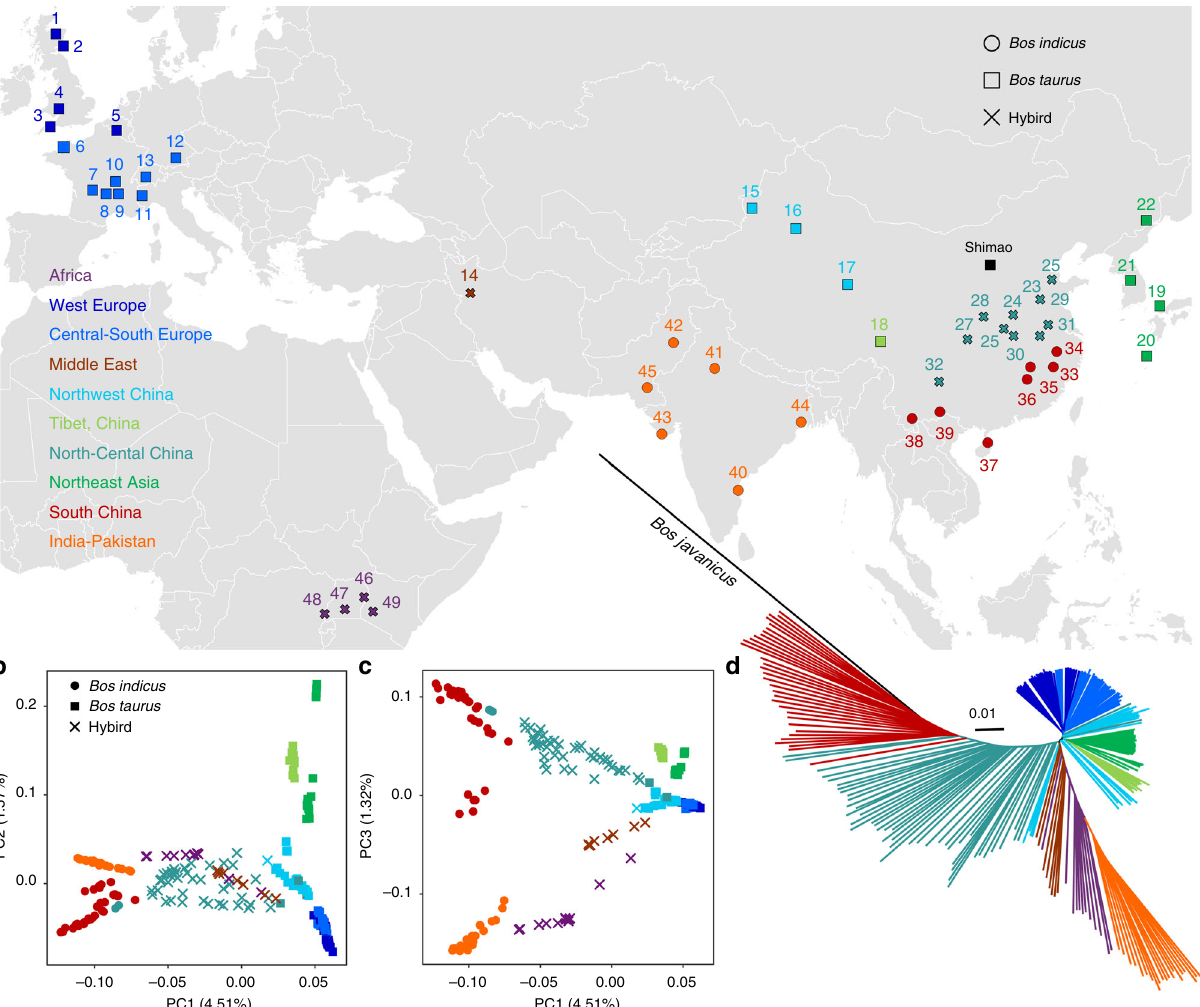
Fig. 1 Population structuring and relationship of East Asian cattle. a Geographic map indicating the origins of the cattle breeds in this study. Breed name associated with serial number is listed in Fig. 2a. Principal component analysis (PCA) showing PC1 against PC2 ( b ) and PC1 against PC3 ( c ). d A neighbour- joining phylogenetic tree constructed using whole-genome SNP data. The scale bar represents pairwise distances between different individuals. Colours re fl ect the geographic regions of